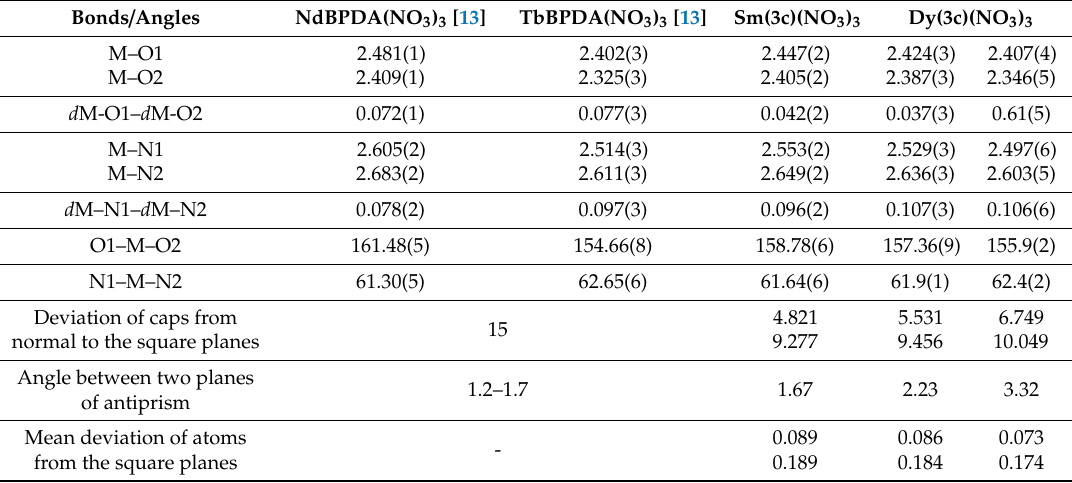
Table 3. Comparison of the interatomic distances (Å) and angles ( ◦ ) in the coordination sphere of the metal ions for complexes of 3c with 2,2 (cid:48) -bipyridyl-6,6 (cid:48) -dicarboxylic acid (BPDA) ligand complexes.